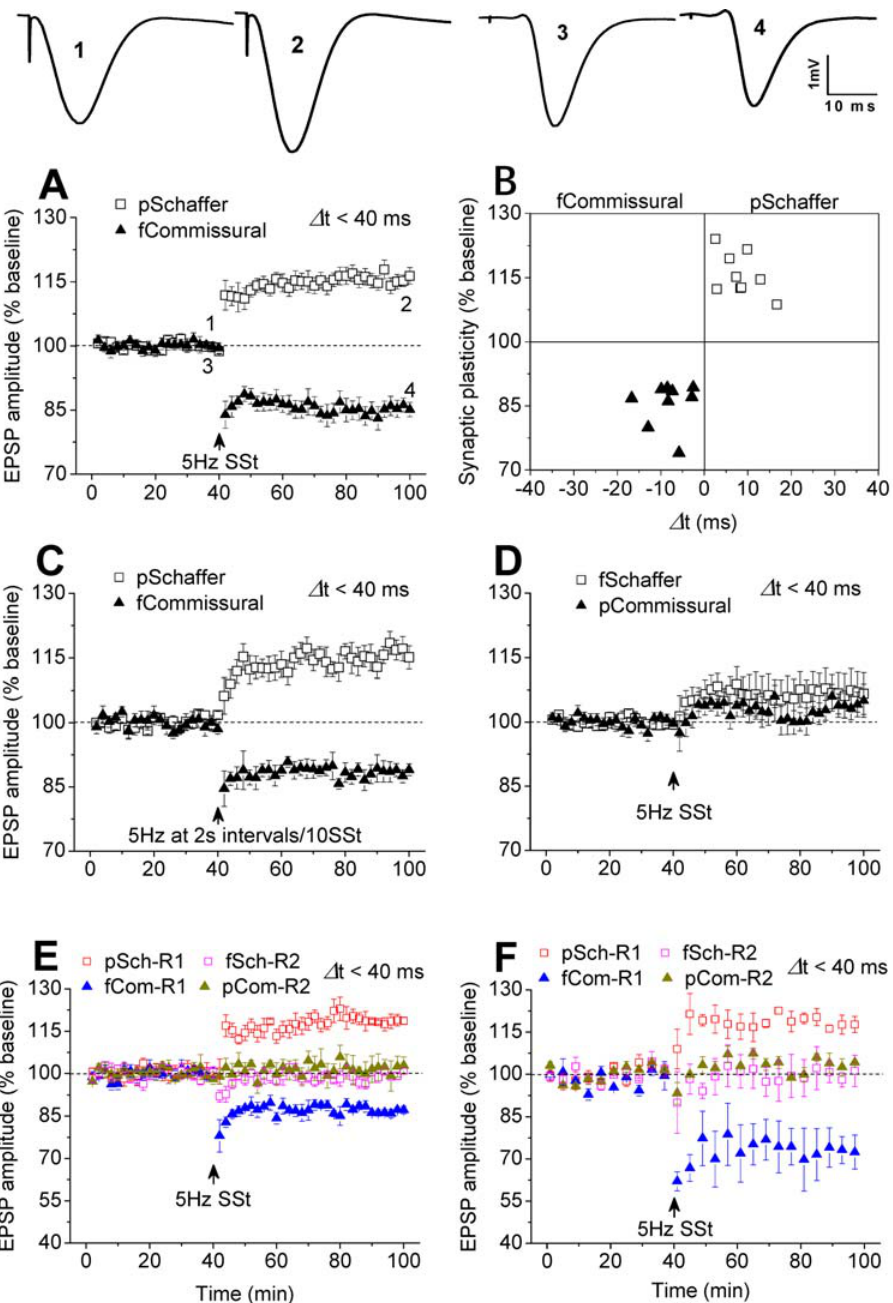
Figure 3. Coincident Schaffer/commissural activity induces LTP and LTD in urethane-anesthetized or freely-moving rats. A , The stimulation to Schaffer preceding to commissural pathway within a timing window of 40 ms induced LTP in the preceding and LTD in the following pathway (n=9; pSchaffer: 116.6 6 1.9%; fCommissural: 84.8 6 2.0%; P , 0.001 vs. baseline of pSchaffer or fCommissural). B , Individual data confirmed consistent LTP and LTD in pSchaffer and fCommissural pathways, respectively. C , Similarly, the modified stimulation, consisted of 600 pulses at 5 Hz with 2 s intervals per 10 pulses, to Schaffer preceding to commissural pathway within 40 ms induced Schaffer LTP and commissural LTD, simultaneously(n=4; pSchaffer: 116.8 6 1.5%, P=0.003 vs. baseline; fcommissural: 88.7 6 2.1%; P=0.011 vs. baseline). D , However, when the activity sequence was reversed in which Schaffer followed commissural pathway within a window of 40 ms, the stimulation had no significant effect on synaptic efficacy in either pathway (n=9; fSchaffer: 106.8 6 4.9%, P=0.061 vs. baseline; pCommissural: 104.0 6 3.8%, P=0.147 vs. baseline). E , In urethane-anesthetized rats, the stimulation to Schaffer preceded commissural pathway induced LTP in the preceding and LTD in the following pathway at R1, but had no effect on synaptic efficacy in the Schaffer followed commissural pathways at R2, within a 40-ms window (n=3, pSchaffer- R1 (pSch-R1): 118.4 6 1.5%, P=0.005 vs. baseline; fCommissural-R1 (fCom-R1): 87.2 6 1.4%, P=0.005 vs. baseline; pCommissural-R2 (pCom-R2); 99.8 6 1.4%, P=0.437 vs. baseline; fSchaffer-R2 (fSch-R2): 101.8 6 3.3%, P=0.352 vs. baseline). F , In freely-moving rats, the stimulation induced LTP in preceding Schaffer and LTD in following commissural pathway (R1); it had no effect on synaptic efficacy in the reversed sequence (R2), within a 40-ms window (n=4; pSch-R1: 117.5 6 3.6%, P=0.002 vs. baseline; fCom-R1: 72.3 6 7.2%, P=0.025 vs. baseline; pCom-R2; 99.9 6 4.8%, P=0.3987 vs. baseline; fSch-R2: 103.4 6 3.4%, P=0.399 vs. baseline).